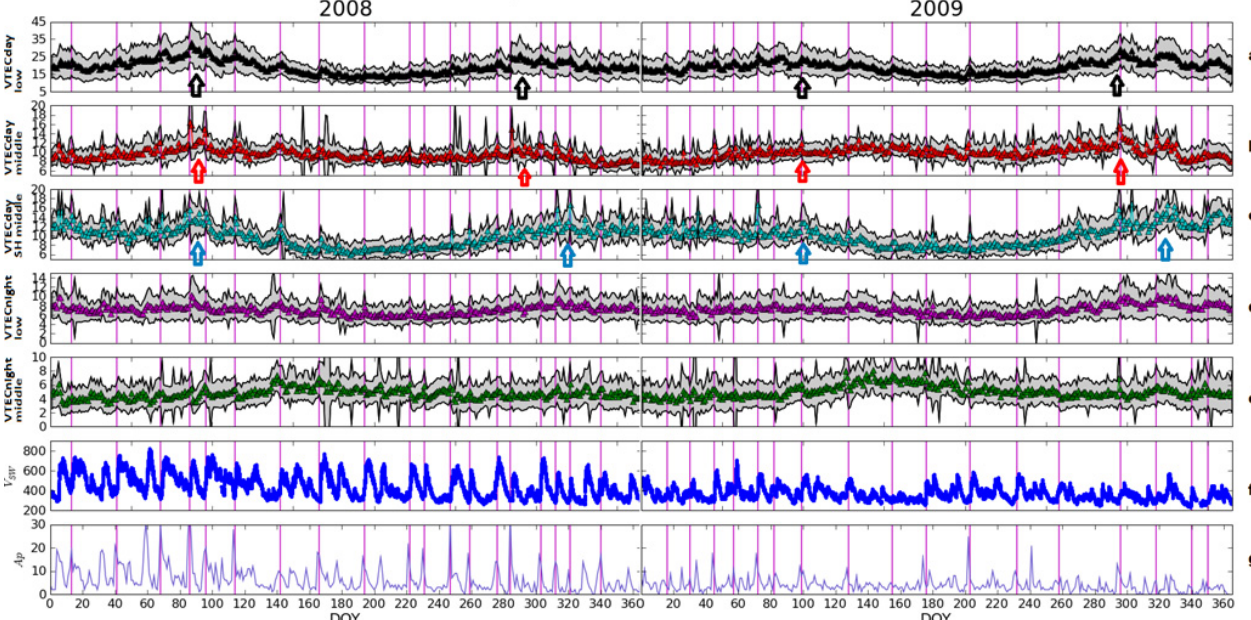
Fig. 1. Daily averaged VTEC values in 2008–2009 in different latitude and LT ranges: (a) low-latitude (from − 30 to 30 ◦ ), (b) northern middle latitude (from 40 to 60 ◦ ), (c) southern middle latitude (from − 55 to − 35 ◦ ) ranges. Daytime values (panels a – c ) correspond to VTEC values within the local time window 12:00 to 14:00LT. Nighttime values for the Northern Hemisphere, near midnight (22:00 to 24:00LT): (d) low-latitude (from − 30 to 30 ◦ ), (e) northern middle latitude (from 40 to 60 ◦ ). Gray shading shows standard deviations of the daily values. Panels (f) and (g) show the solar wind speed at 1AU and Ap index correspondingly (courtesy of the OMNI database at NASA/GSFC). Vertical thin magenta lines indicate selected peaks in daytime low-latitude TEC (panel a ) which correspond to the solar wind speed and Ap increases (panels f and g ). The semiannual maxima in the panels (a) – (c) are indicated by wide black, red and turquoise arrows around the equinoxes. Table 1. Daily VTEC averages statistics for 2008 and 2009. 2008 2009 2003 HSS event Northern Hemisphere Min Average Max Min Average Max Min Average Max Low latitudes 12.36 19.70 33.03 12.93 19.51 29.37 51.76 54.73 58.24 Middle latitudes 7.16 9.60 16.42 7.09 9.79